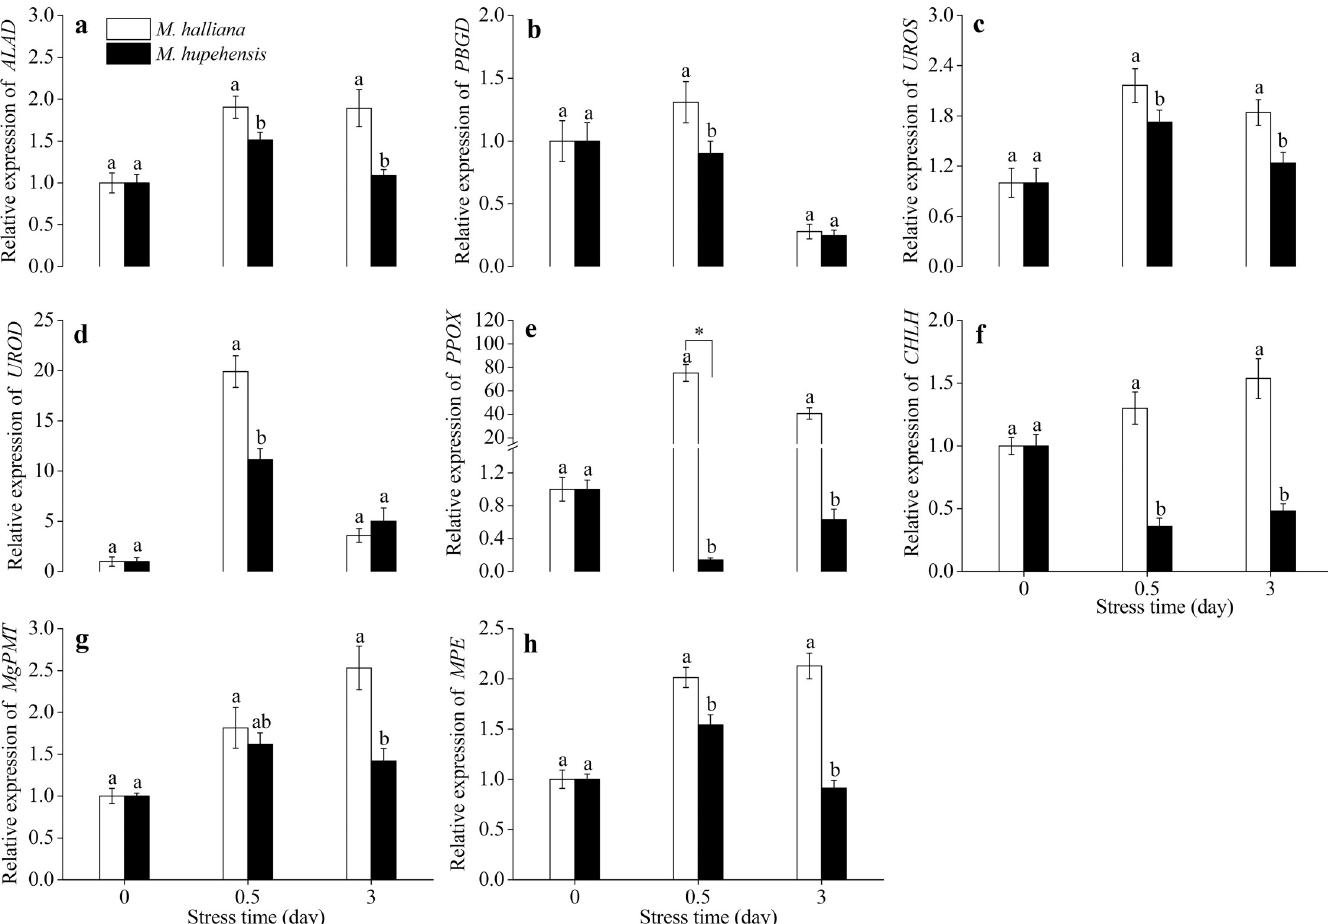
Fig 2. Expression pattern of eight genes in response to Fe deficiency in M . halliana and M . hupehensis . (a)Expression of ALAD . (b) Expression of PBGD . (c) Expression of UROS . (d) Expression of UROD . (e) Expression of PPOX . (f) Expression of CHLH . (g) Expression of MgPMT . (h) Expression of MPE . Data are expressed as the mean ± SD (n = 3). The different letters and an asterisk show significant differences between the two apple rootstocks at each time point ( P <